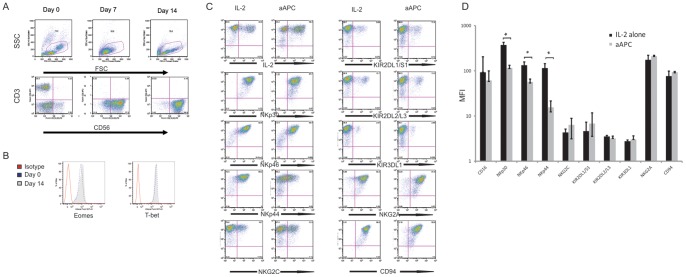
Phenotype of CB-NK cells cultured with aAPCs.A. Over the 14-day expansion, CB-NK cells cultured with aAPC feeder cells demonstrated a progressively pure, CD56+/CD3− population, (representative dot plots of 17 expansions). B. aAPC-expanded CB-NK cells maintained Eomesoderminhi and T-bethi phenotype after expansion. Representative histograms from 3 different CB-NK expansions; cells are gated on the live CD56+ population. C. CB MNCs from the same CB unit were expanded with aAPCs +IL-2 or IL-2 alone (n = 3 separate CB units). Representative dot plots of NK cell surface receptor expression on day 14 are shown. D. By median fluorescence intensity (MFI), aAPC-expanded CB-NK demonstrated a decreased surface expression of the NCRs NKp30, NKp46 and NKp44. However there was a similar expression between the conditions of the KIR antigens, inhibitory receptor NKG2A, co-receptor CD94 and activating receptor NKG2C) (n = 3 paired expansions, mean +/− SD is shown, p≤0.05 where indicated).